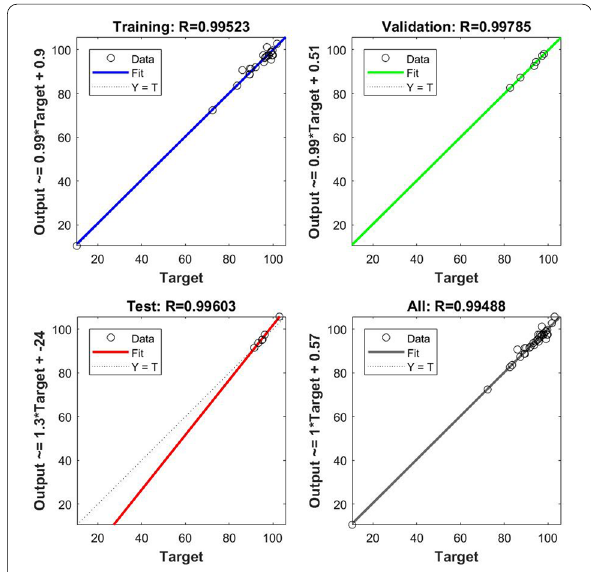
Fig. 5 Outcomes of ANN algorithm for estimation of recovery